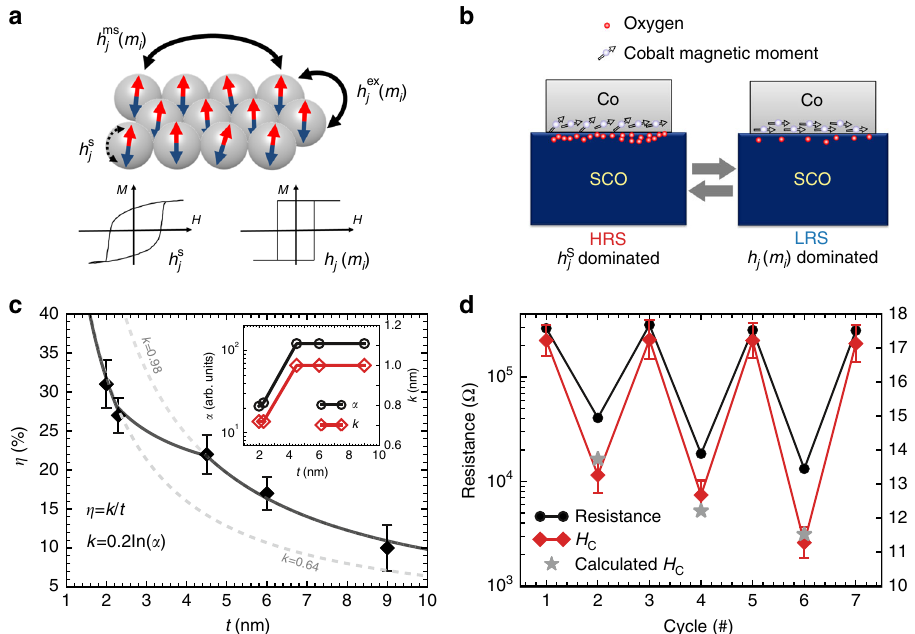
Fig. 4 Magnetoelectric coupling via interfacial oxygen ion gating. a Schematic diagram of magnetic interactions in granular thin fi lms. The hysteresis loops represent the extreme cases when intrinsic spin fl ipping h s j and inter-granular exchanges h j m i ð Þ dominate, respectively. b Schematic diagram of the magnetoelectric coupling via the segregated oxygen ionic accumulation-induced pinning effect and magnetic anisotropy at the interface, where the intrinsic magnetic fl ipping fi eld h s j is enhanced for the high-resistance state (HRS). c Co thickness ( t ) dependence of the magnetoelectric coupling for Co/SrCoO 2.5 (cid:2) H LRS Þ = H HRS heterostructures. η is calculated by ð H HRS as mentioned above, while the fi tting function is de fi ned as η = k / t . The inset shows the correlation C C C between the coercive fi eld modulation and the ON/OFF ratio of the resistance switch. The error bar is calculated from the standard deviation of results obtained in fi ve different devices. d Magnetoelectric coupling with control of oxygen ion gating. The device is set to HRS at the beginning, and then different current limits are set to create the low-resistance state (LRS) with varied resistance values. For each LRS, the coercive fi eld ( H C ) was obtained through the measurement of the magnetic hysteresis. The star symbols represent the calculated H C values from the ON/OFF ratio during the resistance switch. The error bars indicate the standard deviation from 10 measurements under an identical resistance